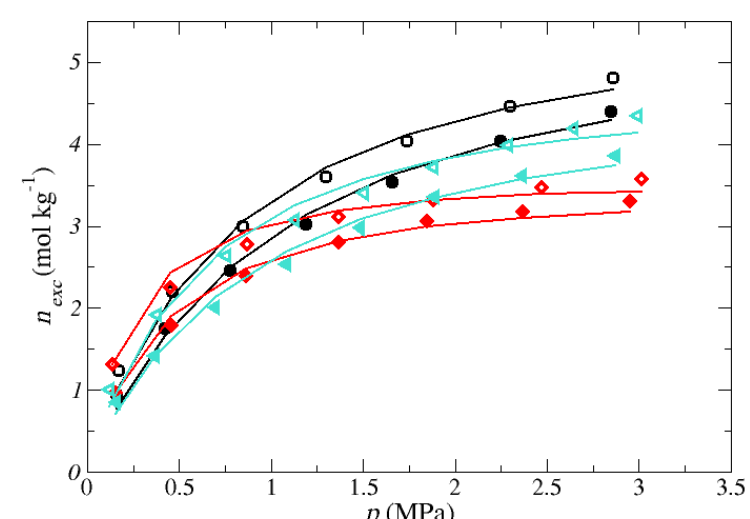
Figure 2. CH 4 adsorption isotherms for the three olive stone-based activated carbons: AC-H 3 PO 4 (black circles), AC-CO 2 (red diamonds) and AC-H 2 O (turquoise triangles). Open symbols represent the adsorption data at 303.15 K, while the data at 323.15 are shown by the filled symbols. Uncertainties: ∆ p = 0.01 MPa, ∆ T = 0.2 K. The obtained Langmuir fitting isotherms are shown by the solid